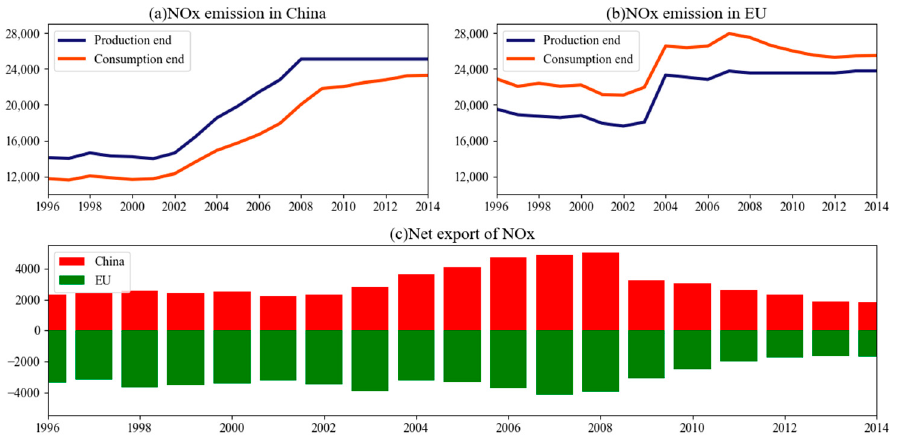
Figure 2. NO x emission amounts of China and the EU based on the production and consumption ends (Unit: kiloton).